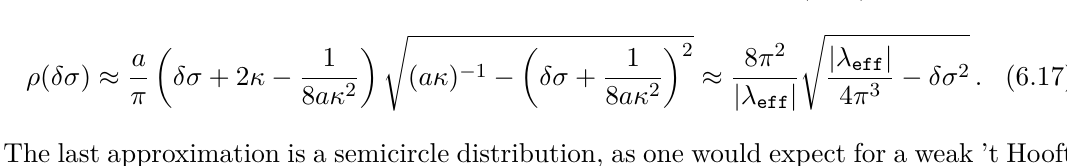
Figure 8 . Eigenvalue density ρ ( δσ ) for λ the analytical solutions (6.6) and